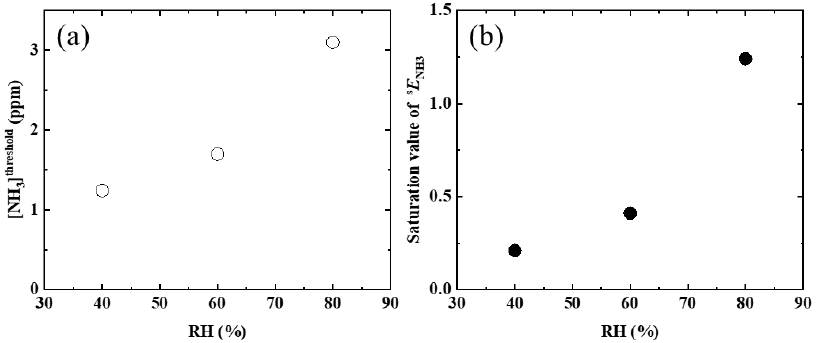
Figure 4. Dependence on RH of ( a ) the [NH 3 ] at which PL enhancement began to be observed threshold ) and ( b ) saturated E ([NH 3 ] threshold ) and ( b ) saturated E NH3 ( s E NH3 ). ([NH 3 ]